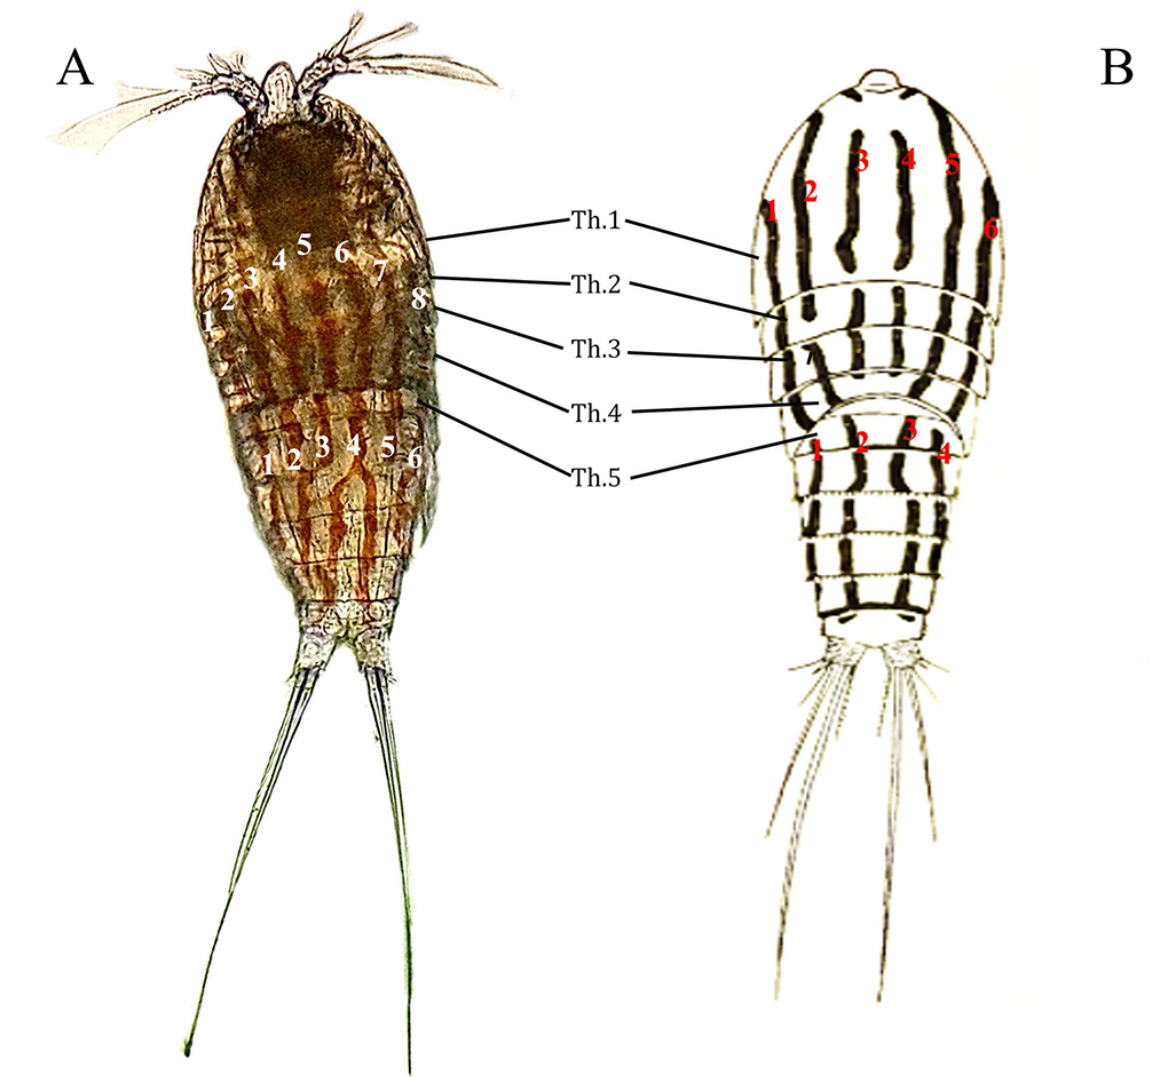
Figure 10. Eudactylopus fasciatus Sewell, 1940. A, Bangaram specimen (Bangaram Islands, Lakshadweep, southwestern Arabian Sea, Indian Ocean); B, Sewell’s (1940) specimen (Andaman and Nicobar islands, Nancowry (= Mankauri) Harbour, northestern Indian ocean). Th.1- Th.5 (Thoracic segments